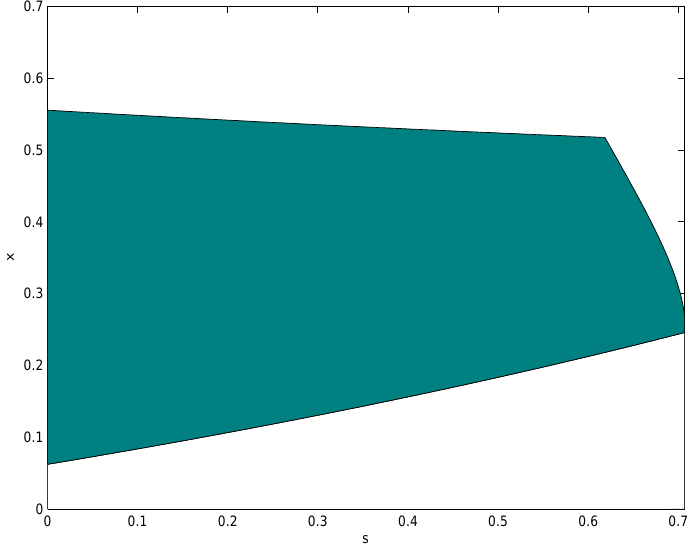
Note: The shaded area includes all the values of cost differences–captured by the parameter Figure 1. Values of cost differences and overconfidence for which there exists a cost-dependent x – and overconfidence–captured by the parameter s –for which there exists a cost-dependent equilibrium. The shaded area includes all the values of cost differences—captured by the equilibrium. parameter x —and overconfidence—captured by the parameter s —for which there exists a cost-dependent